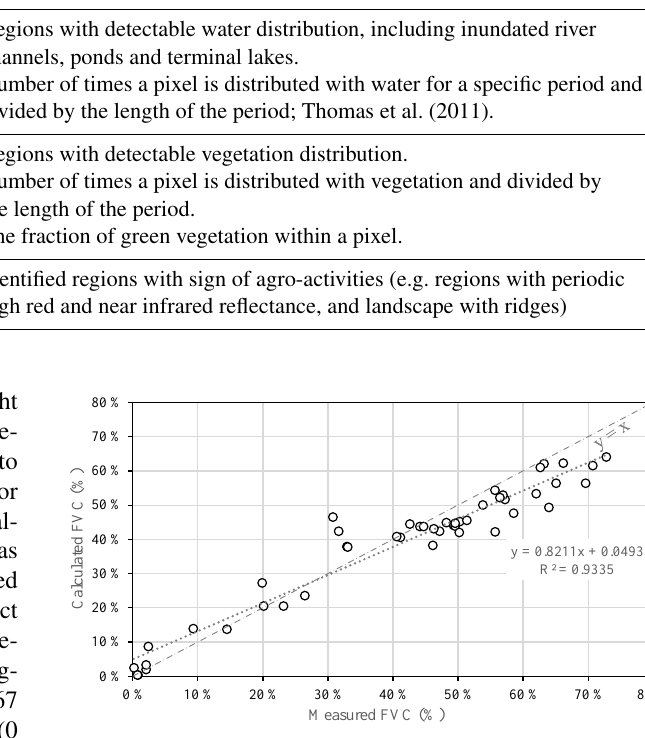
Figure 2. Comparison between the calculated and measured FVC values in 54 sites within HRB in